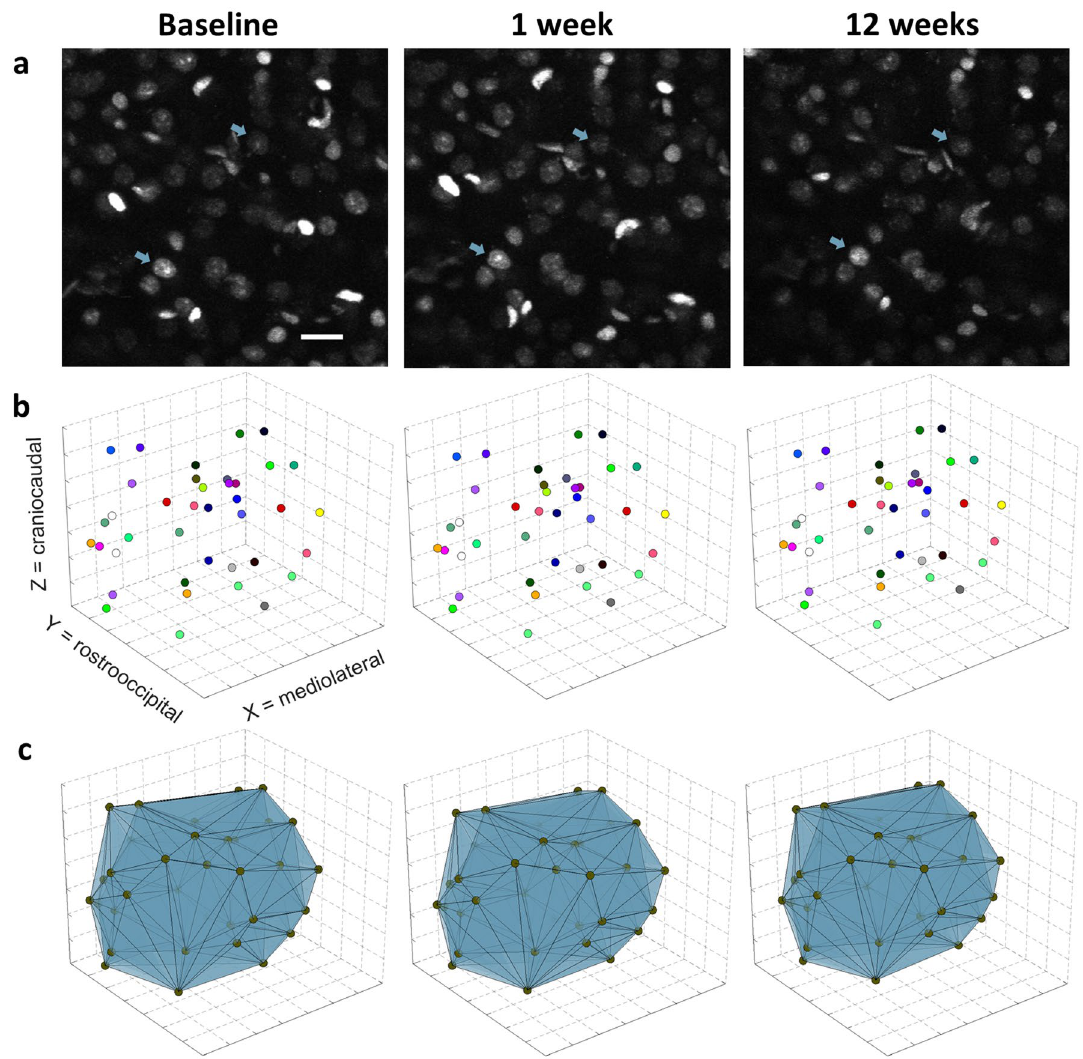
Figure 5. Determination of physical tissue volume from a convex hull spanned between nuclei reidentified over time. ( a ) Stable patterns of nuclei were reidentified over all timepoints and nucleus centre coordinates were sampled as fiducial markers throughout all stack dimensions. Two examples of reidentified nuclei are indicated by blue arrows. Maximum intensity Z-projection of 10 optical sections covering 20 µm. Scale bar = 20 µm. ( b ) Fiducial marker coordinates plotted inside single stack volume. Dot colours specify fiducials that could be reidentified reliably at all three time points. Grid lines spaced in 100 µm. ( c ) Three-dimensional Delaunay triangulation from fiducials create matching tetrahedra. All tetrahedra create a convex hull (entire volume in blue) whose subtle volume changes indicate shrinkage or expansion of the tissue